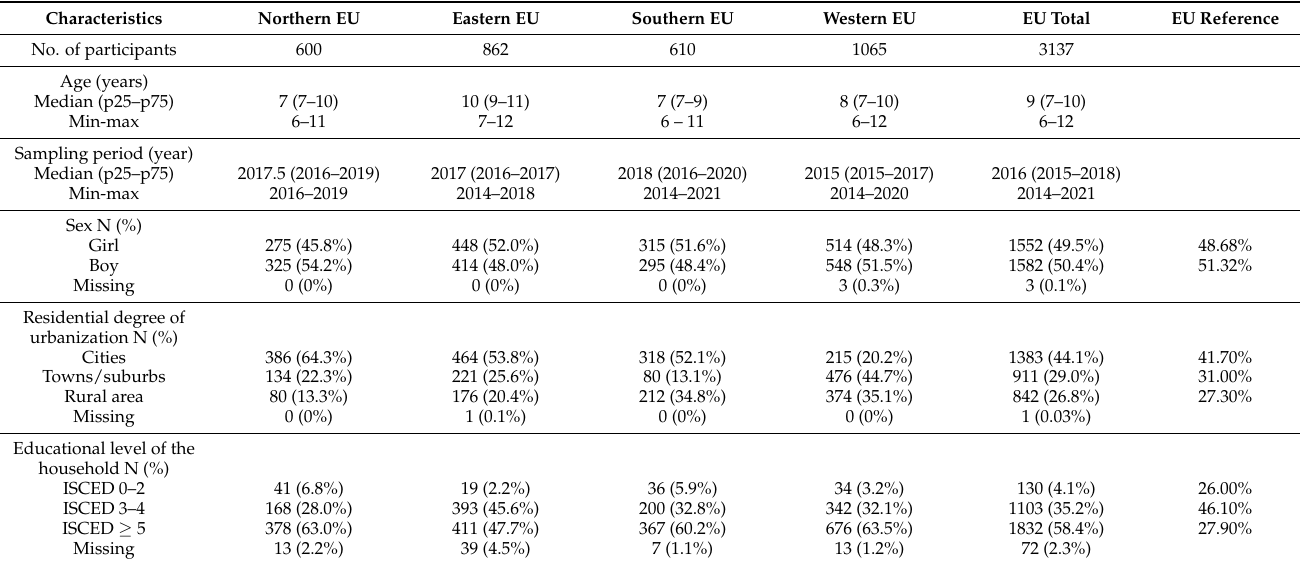
Table 5. Characteristics of sampled population children by European region and in